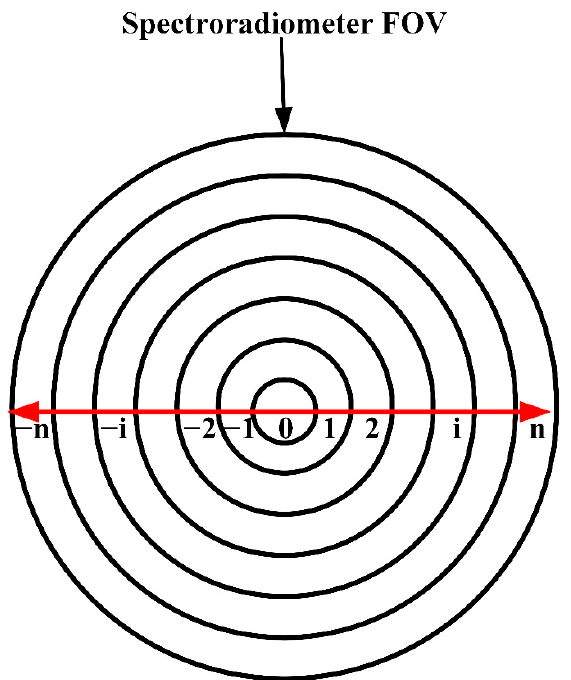
Figure 1. Schematic diagram of the concentric-circles method.